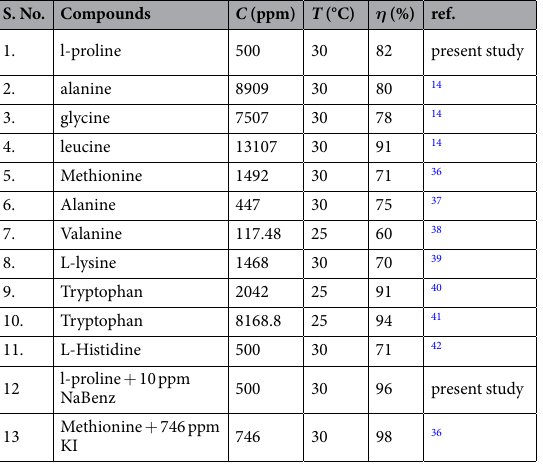
Table 4. Comparison of the inhibition efficiency of studied inhibitor with other amino acids obtained for MS in acidic media reported in the literature.